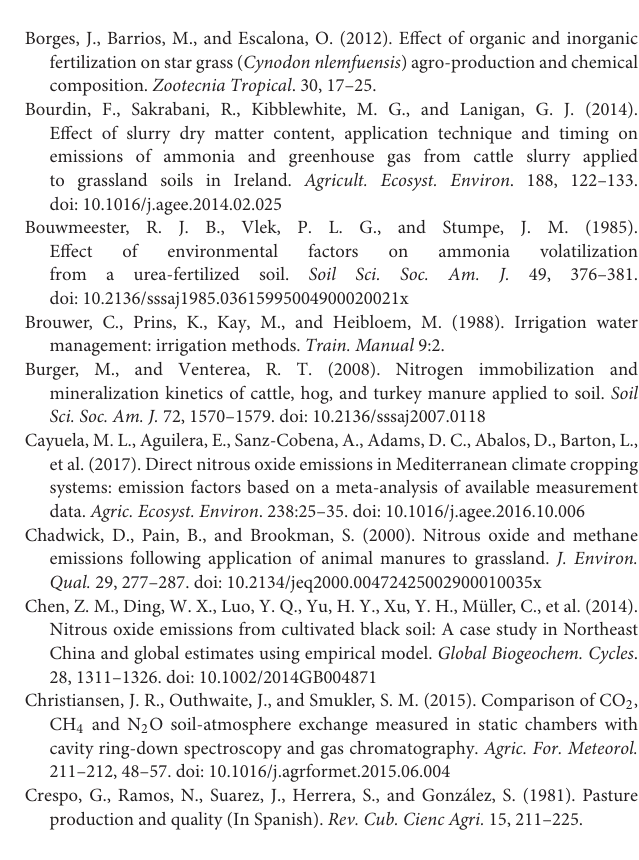
Supplementary Figure 1 | Plots distribution scheme of the treatments control (CK), surface application of dairy farm effluents with (SNI) and without nitrapyrin (S) for monitoring biomass and protein crude (A) and flux of gases (B) , in a field trial conducted in 2017 on a permanent pasture in the Alfredo Volio Mata Experimental Station, Costa